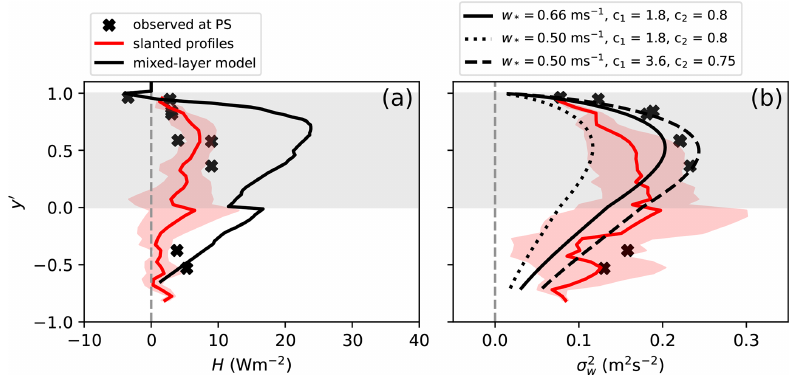
Figure 14. Observed and diagnosed turbulent heat flux profiles for 5 June (a) and vertical velocity variance (b) obtained using the Lenschow et al. (1980) parameterization (Eq. C17) with w ∗ = 0 . 5ms − 1 and w ∗ = 0 . 66ms − 1 and with modified constants c 1 and c 2